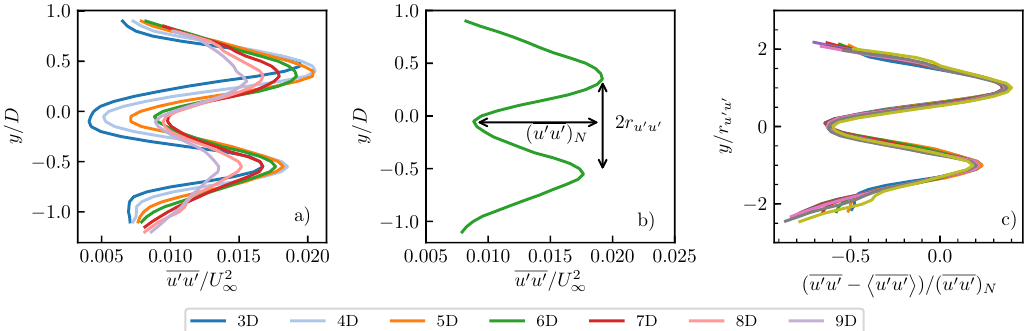
Figure 10. The normalization for the spanwise profile of the Reynolds stress component u (cid:48) u (cid:48) . In ( a ), the spanwise profiles are normalized by a fixed scale for all downstream distances. In ( b ), the definitions of the characteristic scales in u (cid:48) u (cid:48) are annotated. In ( c ), the spanwise profiles in 4 normalized by the characteristic scales. In the normalization, of u (cid:48) u (cid:48) for grid points between the two positive peaks.